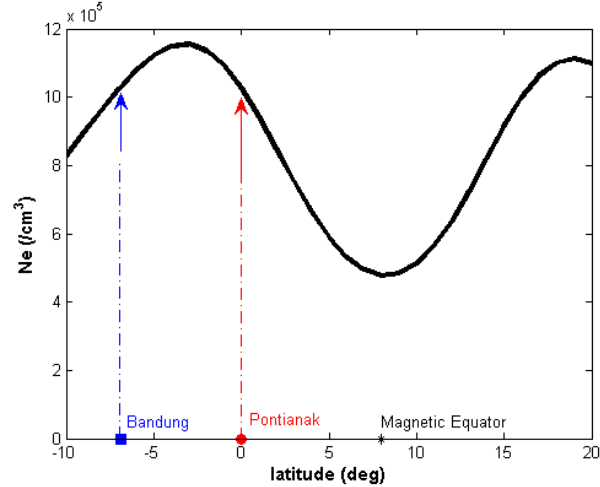
Fig. 8. The typical condition of electron density plotted against lat- itude in the Indonesian Figure 8. Typical condition of electron density plotted against latitude in Indonesian sector. 3